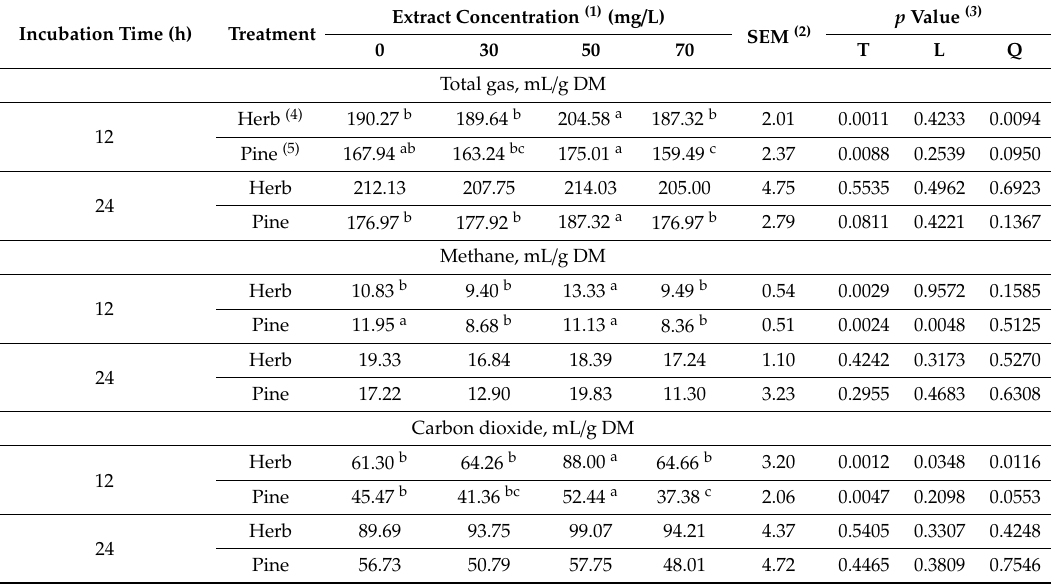
Table 4. E ff ects of terpene-based plant extracts on gas profiles after 12 and 24 h of in vitro incubation. Incubation Time